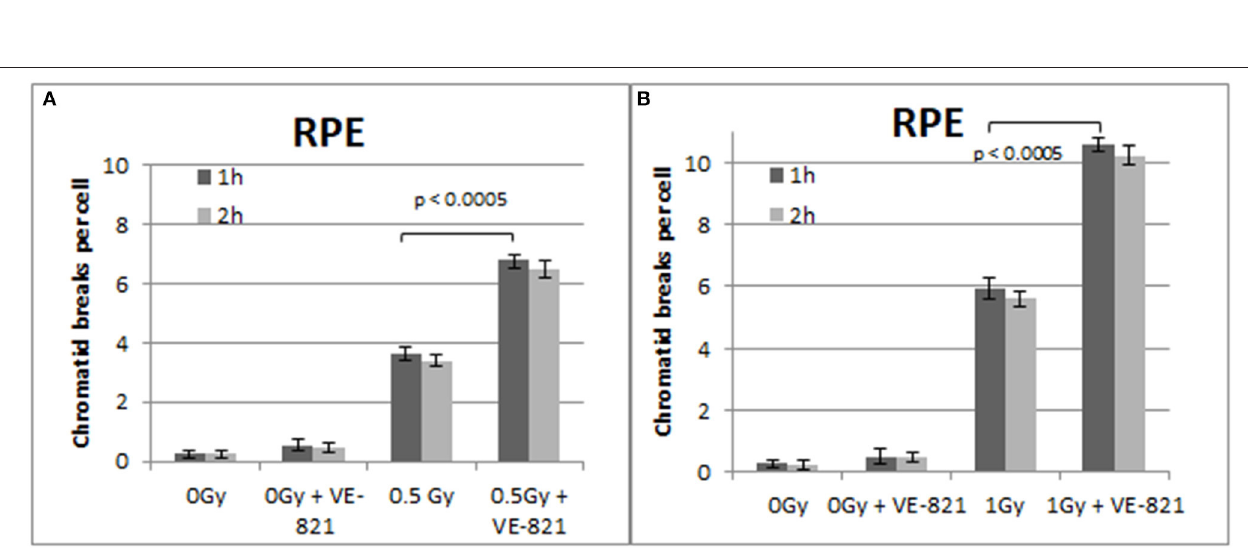
FIGURE 6 | (A) Yield of CBs in the RPE cells, treated with VE-821 or left untreated, following exposure to 0.5Gy. (B) As in (A) for cells exposed to 1Gy. Cells were harvested at 1 and 2h after IR (Mean ± SD based on three independent experiments; statistically significance criterion: p ≤